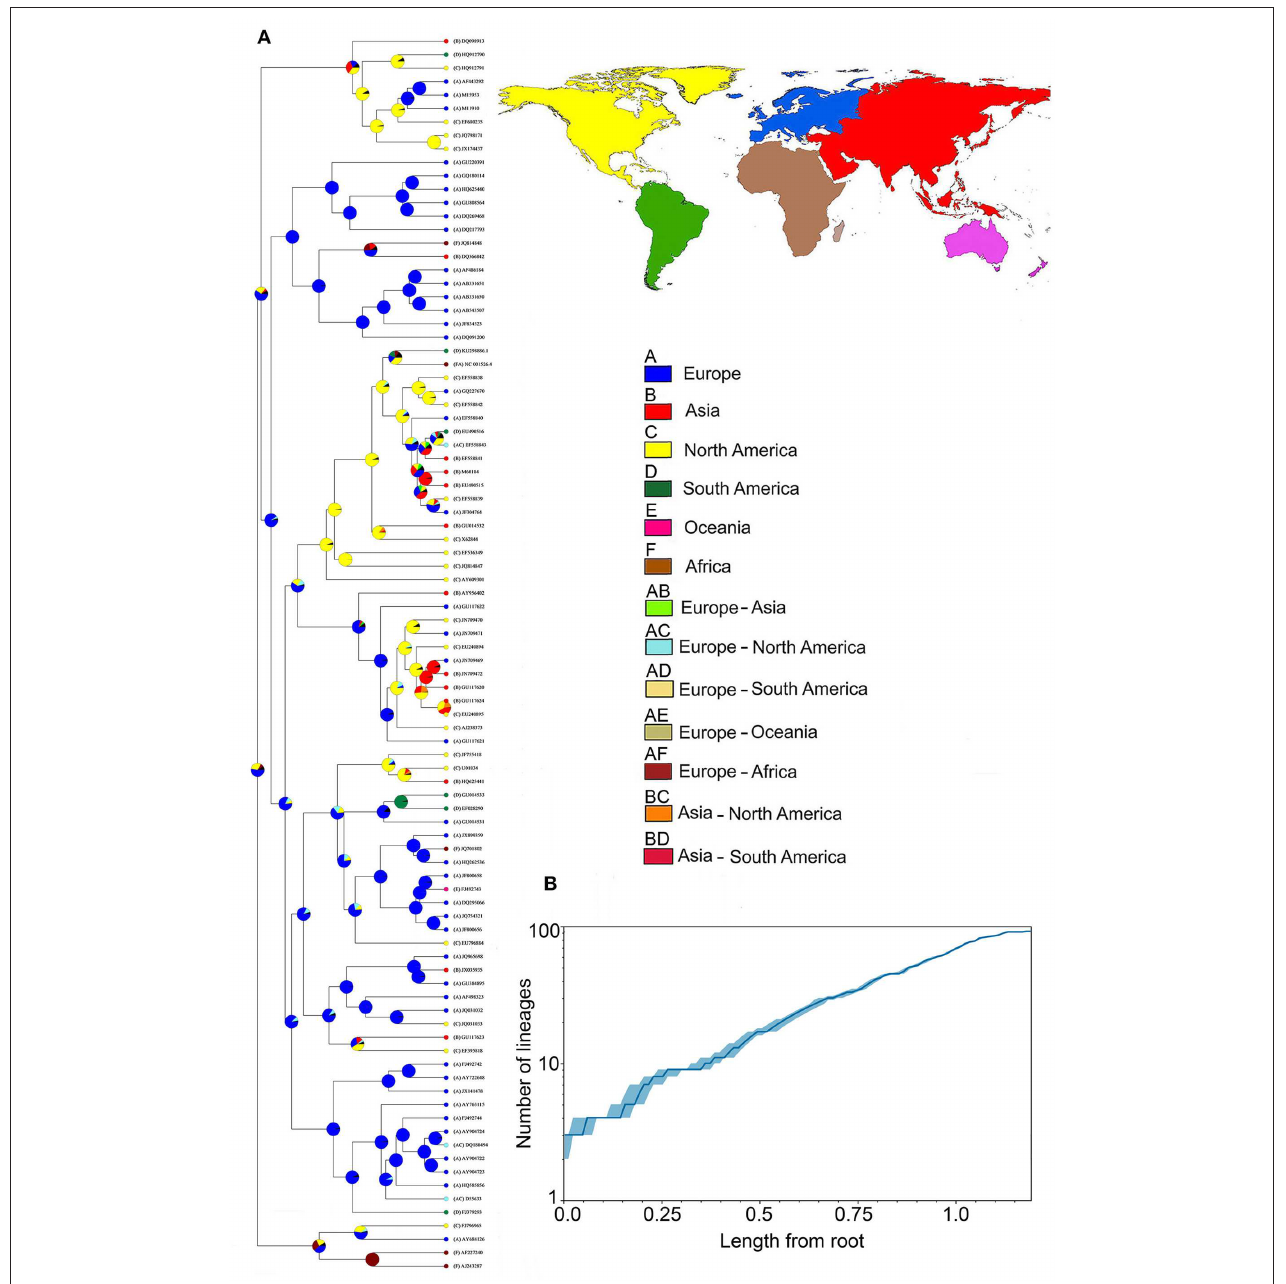
FIGURE 4 | Phylogeography of papillomavirus in wildlife (WPV). (A) Reconstruction of the evolutionary history of mammalian WPV; Tree tips: GenBank ID numbers of the analyzed samples; Nodes: most likely origin of the lineages at that time-point, being (a) blue: Europe; (b) red: Asia; (c) yellow: North America; (d) green: South America; (e) fuchsia: Oceania; and (f) brown: Africa. The combination of two continents includes: (ab) light green: Europe/Asia; (ac) light blue: Europe/North America; (ad) beige: Europe/South America; (ae) light brown: Europe/Oceania; (af) terracotta: Europe/Africa; (bc) orange: Asia/North America; (bd) light red: Asia/South America; (B) Rate of lineage diversification (i.e., number of appearing lineages over time; solid line) showing the magnitude of WPV geographic spread ( x axis) in relation to the appearance of new lineages ( y axis). The median estimated of the number of lineages through time is represented by the dark blue. The 95% highest posterior density confidence intervals are marked in light